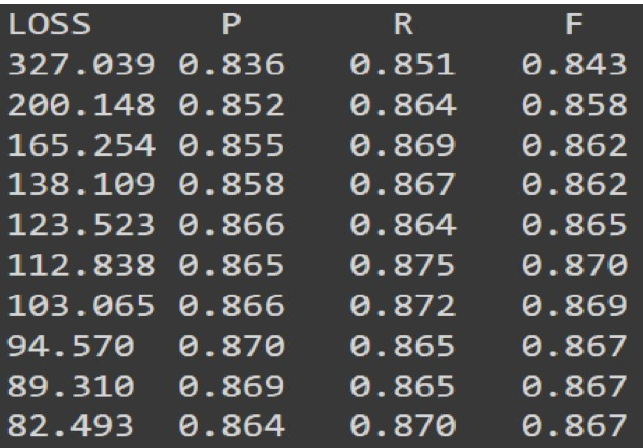
Fig. 6. Training data for 10 epochs